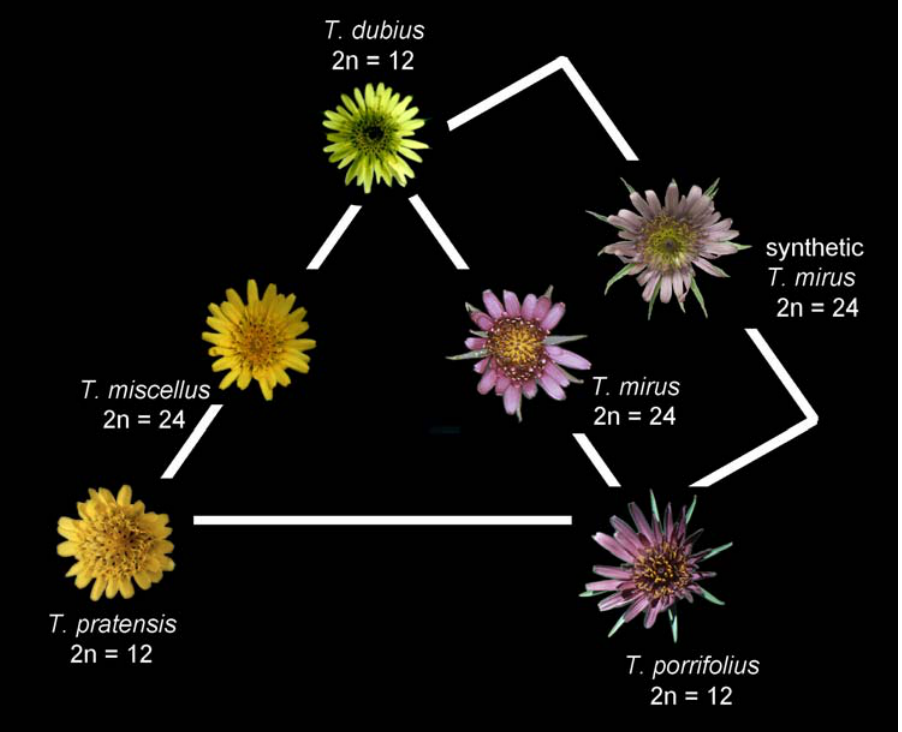
Figure 1. Tragopogon triangle with the flowers of the diploid Tragopogon species at the apices of the triangle. The flowers of the polyploids T. miscellus and T. mirus are shown between their respective diploid parents. The synthetic polyploid described here has the same parents as T. mirus .